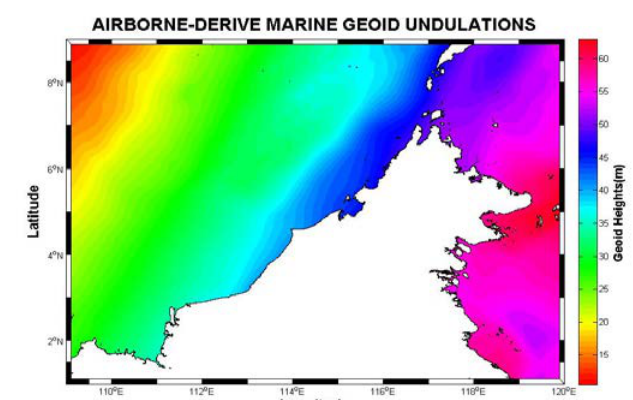
Figure 3. Airborne track in Sabah